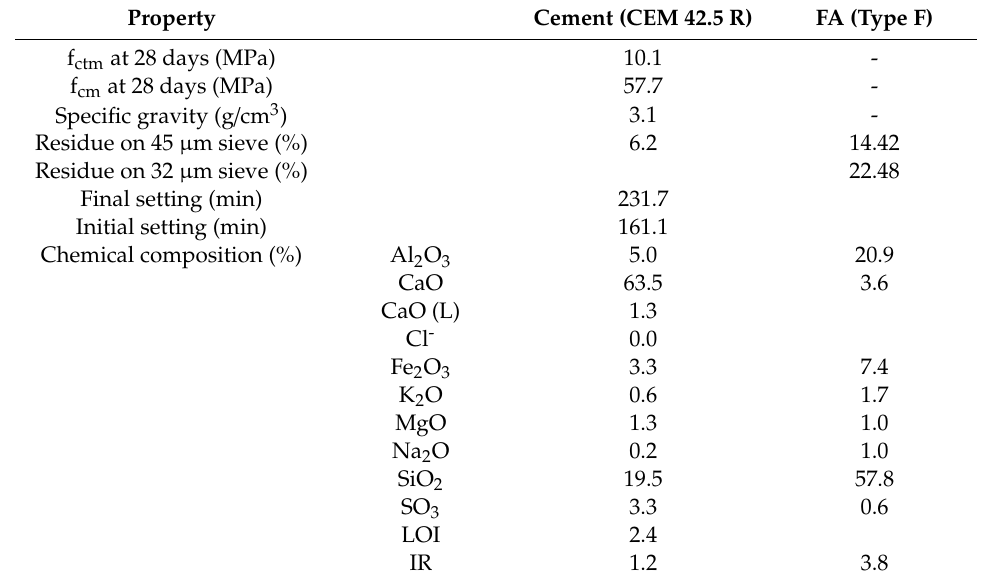
Table 1. Characterization of cement and FA.